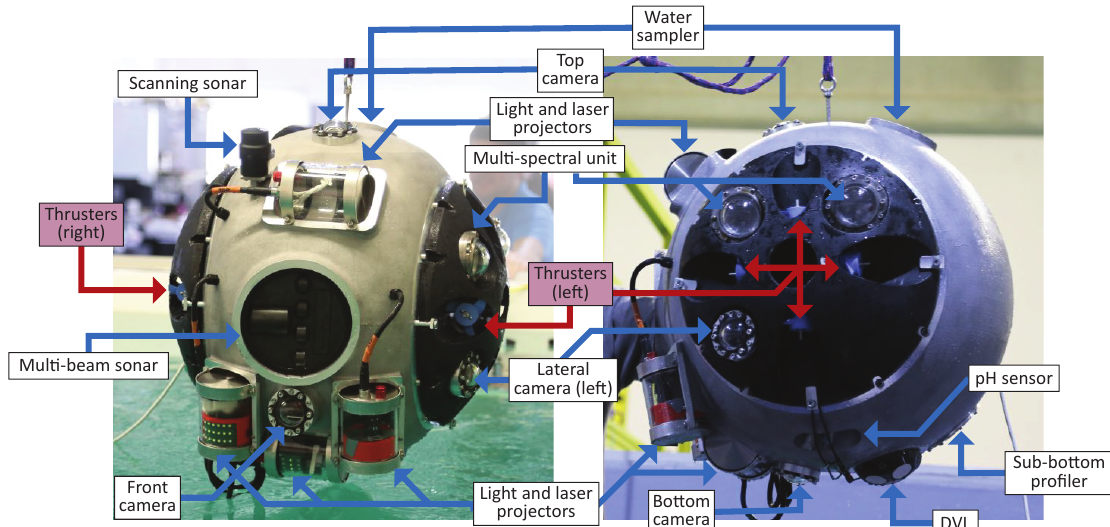
Figure 3. Scientific, navigation equipment, and thrusters of the UX-1 robot: left image, front view of the UX-1; right image, left side view.